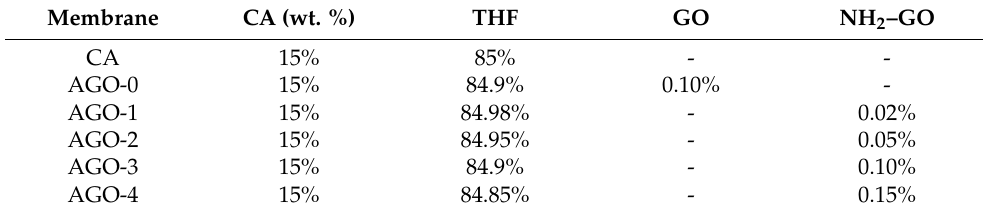
Table 1. Concentrations of different AGO